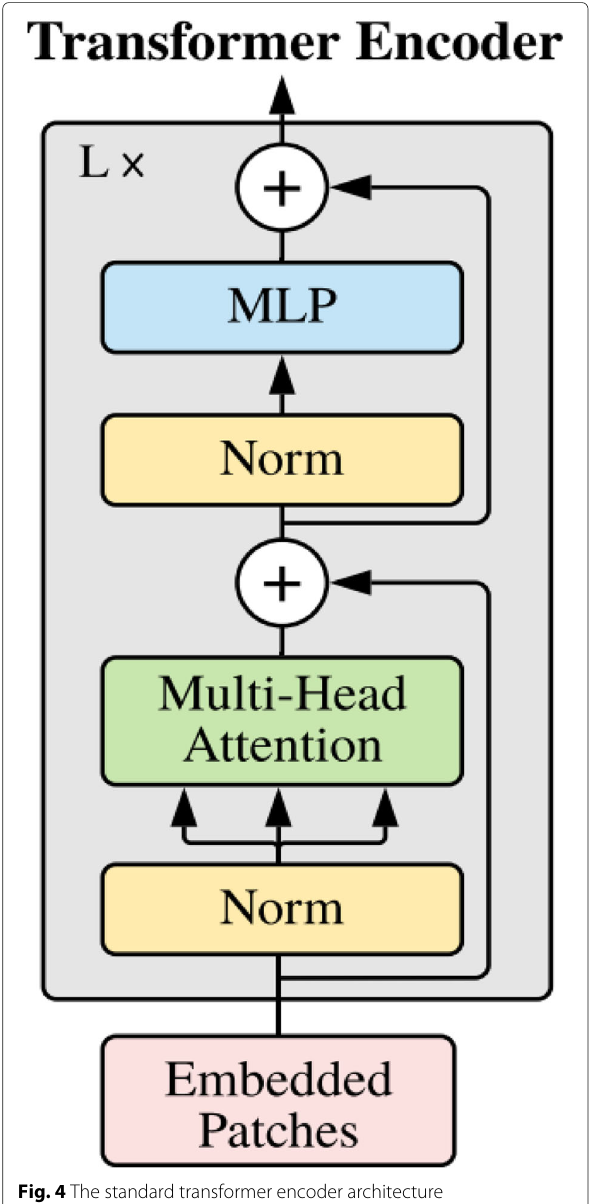
Fig. 4 The standard transformer encoder architecture